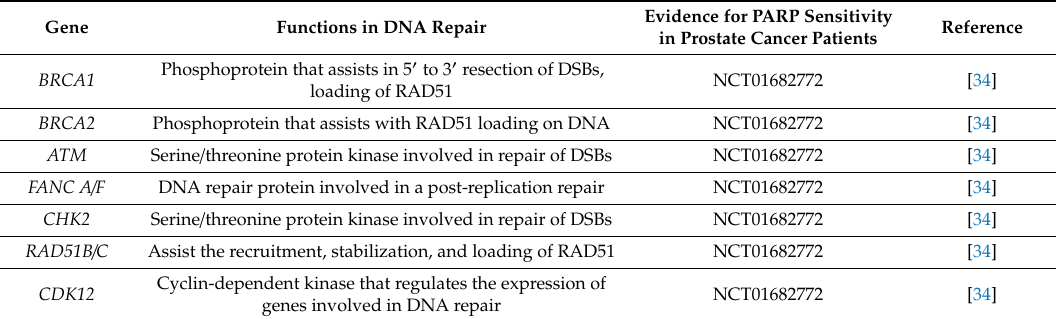
Table 1. DNA repair genes that predict PARP-inhibitors